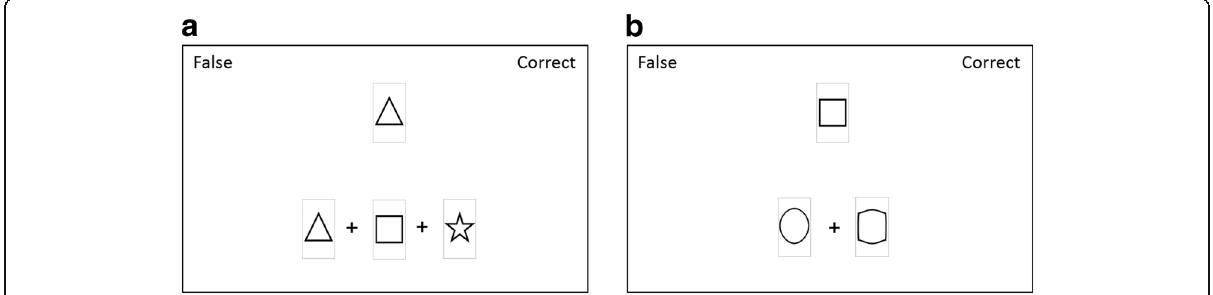
Fig. 3 Stimuli in the schema application task: a difficult condition with prototypical symbols and b easy condition with distorted symbols